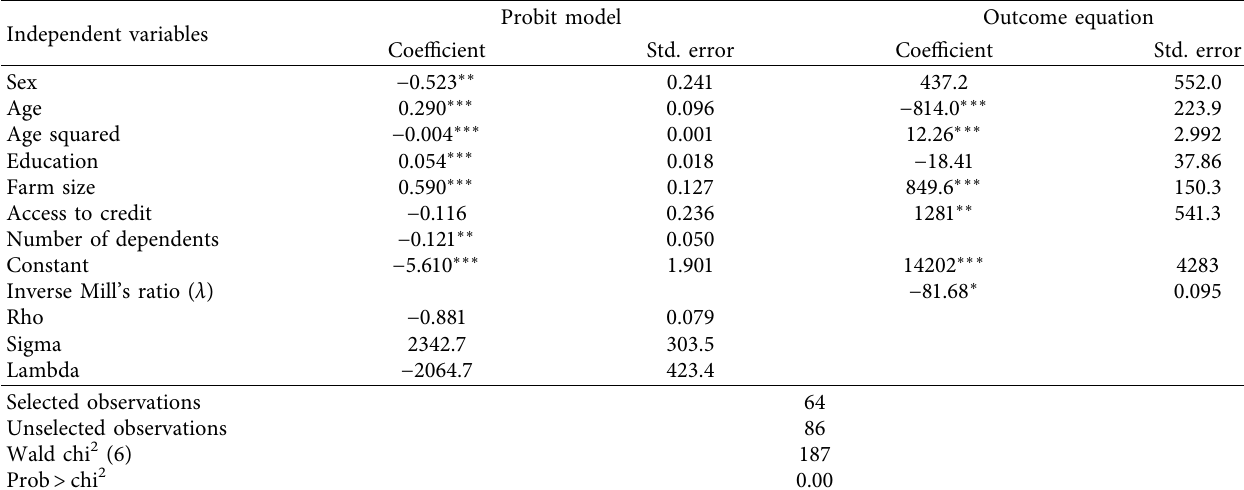
Table 4: Results of the Heckman selection model of off-farm work and farm